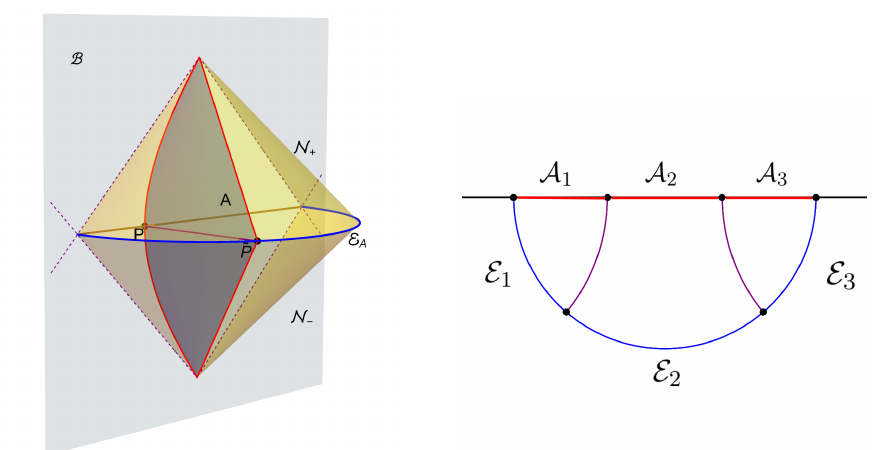
Figure 6: Figures extracted from [ 54 ] , licenced under CC-BY 4.0. The left figure shows the slicing of the entanglement wedge with modular slices (the blue surface with red boundaries). The right figure shows a time slice of the entanglement wedge and the correspondence between the partial entanglement entropies and geodesic chords on E . The purple lines are where the modular slices intersect with the time A slice.